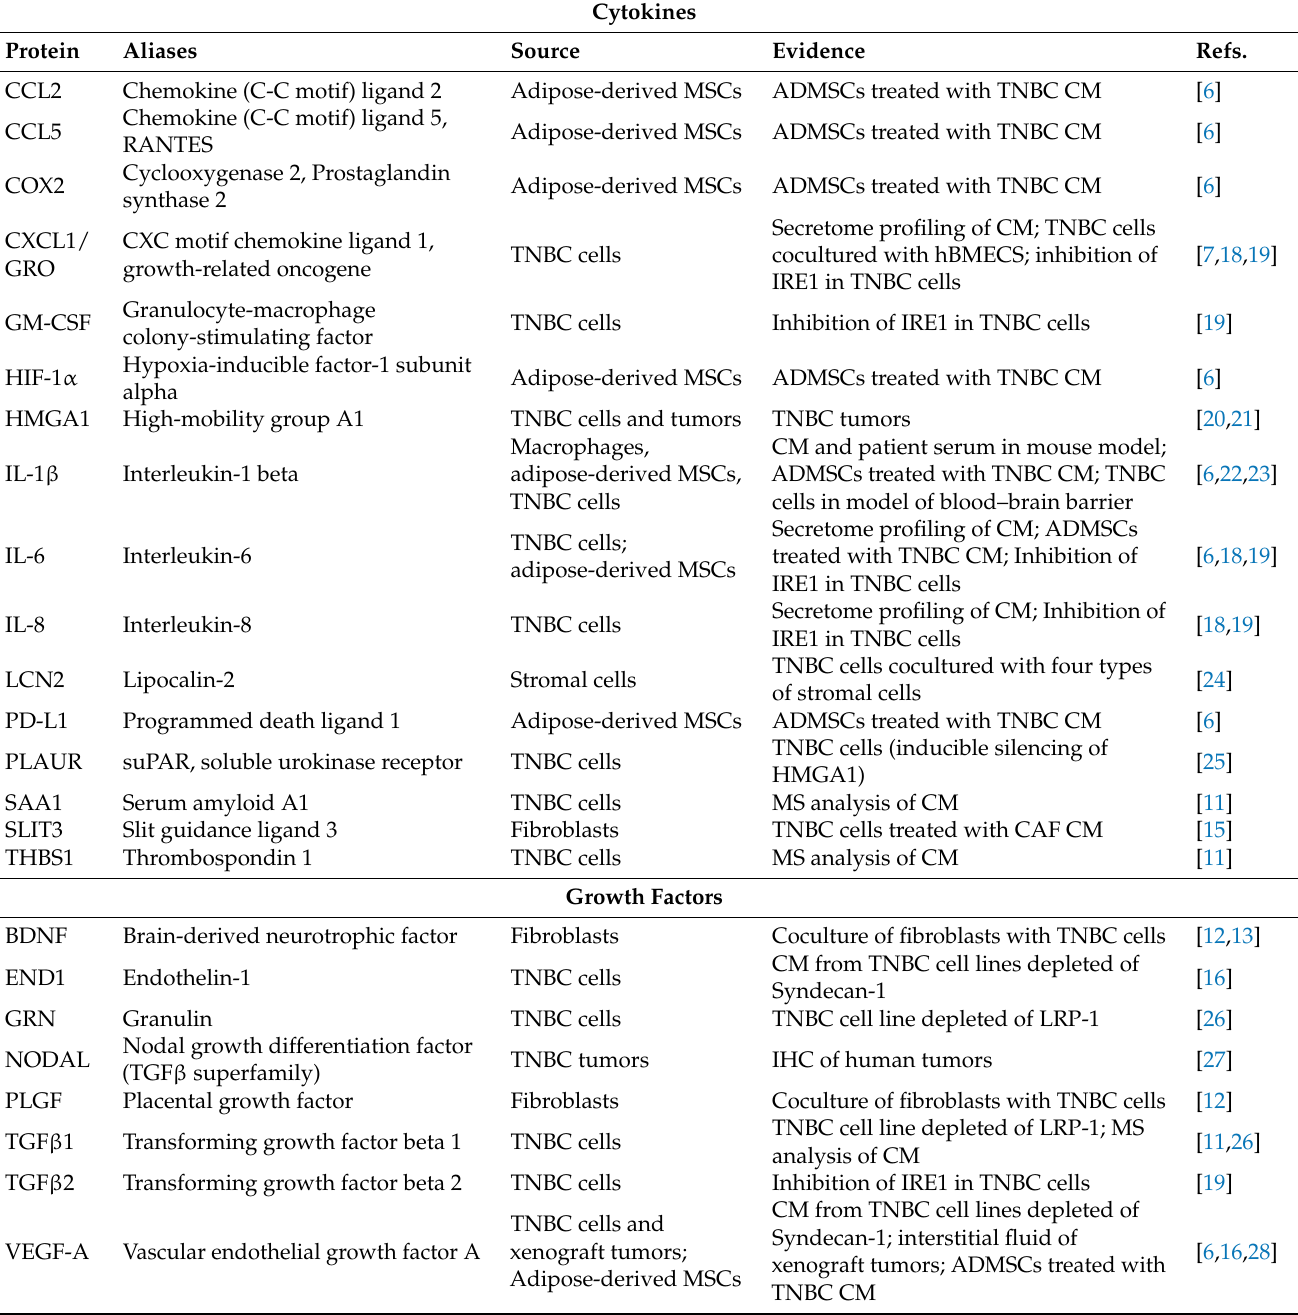
Table 1. Cytokines and Growth Factors of the TNBC